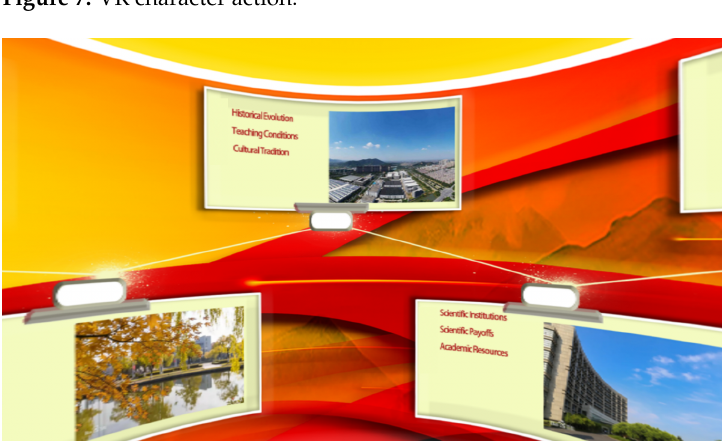
Figure 8. VR school history museum.